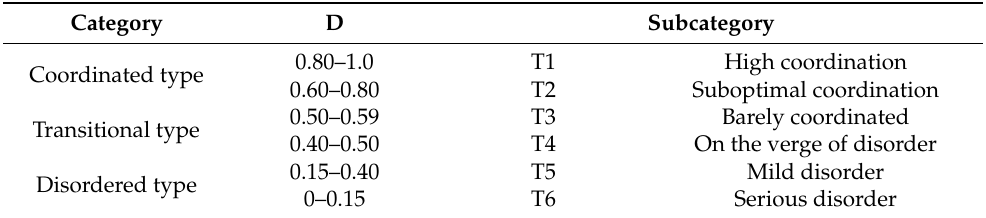
Table 3. Classification of degree of coupling